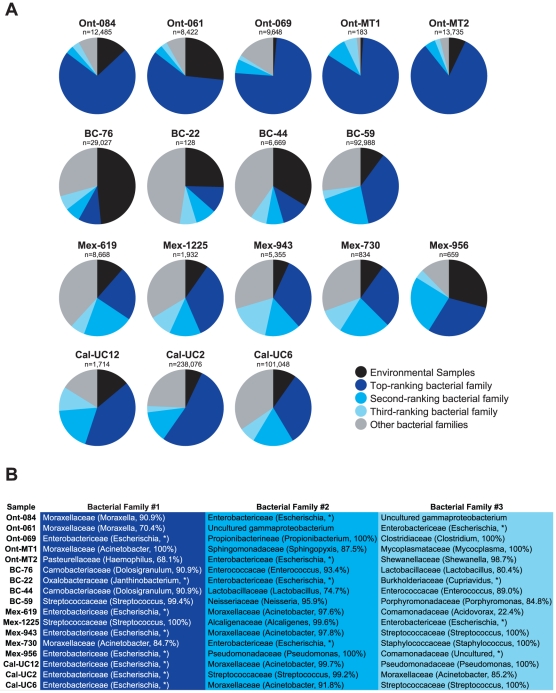
Deep sequencing analysis of bacteria in 2009 H1N1 samples.All bacterial reads aligned to bacterial rRNA and are classified only at the genus level (family level for Enterobactericeae). (A) The pie charts depict the proportion of bacterial rRNA reads corresponding to the top-ranking (dark blue), second-ranking (medium blue), and third-ranking (light blue) bacterial families, as well as other remaining families (grey) and unidentified environmental samples (black). (B) For each sample, the identities of the top-ranking, second-ranking, and third-ranking bacterial family, as well as the majority genus within each family, are shown.